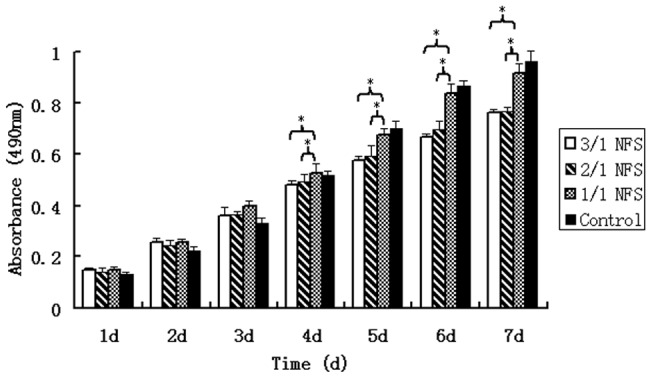
MTT assay of hASCs on different NFS.From day 1 to 7 after fabrication of hASCs and NFS, the cell numbers expressed as absorbance of MTT assay increased continuously. From day 4, the hASCs number in 1/1 NFS was significantly higher than 3/1 and 2/1 NFS (both p<0.05). But the difference between 1/1 NFS group and control group was not analyzed to be a statistical significance (p>0.05). * indicated there was a statistically significant difference between the two groups connected by a by a bracket.